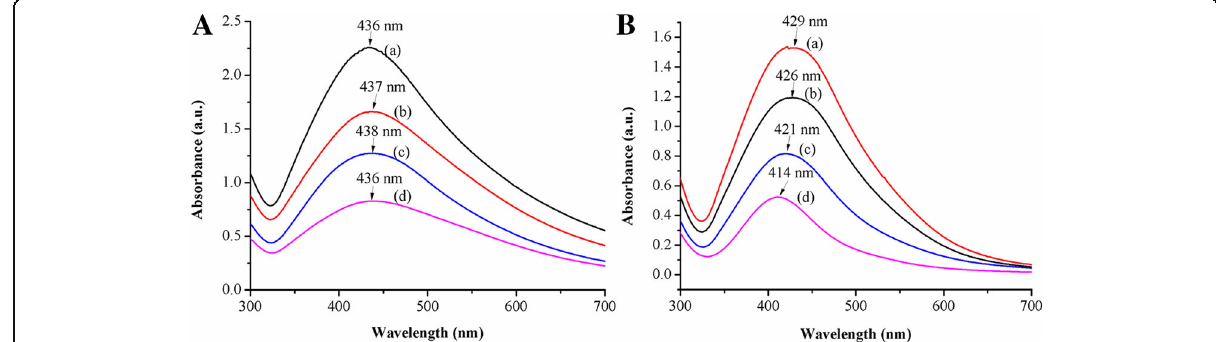
Fig. 3 UV-Vis spectra of a linear and b star copolymers micelles stabilized AgNPs at different PDMAEMA/AgNO 3 molar ratios of (a) 1/1, (b) 3/1, (c) 6/1, (d)